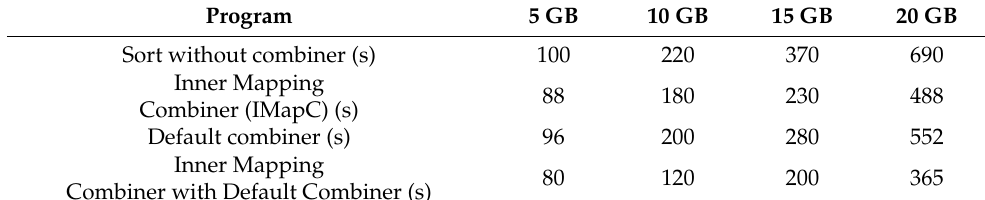
Table 5. Performance improvement of IMapC with Default Combiner on running Sort program in TFR.